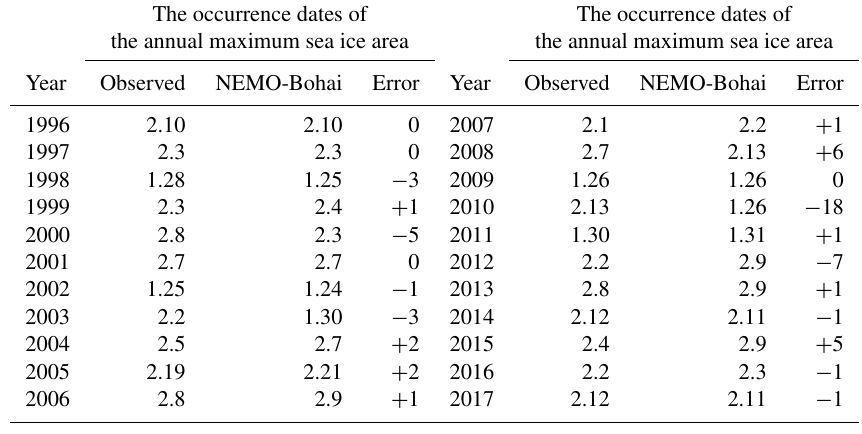
Table 4. Comparison of the occurrence dates of the annual maximum sea ice area between the observations and model simulations. The occurrence dates of The occurrence dates of the annual maximum sea ice area